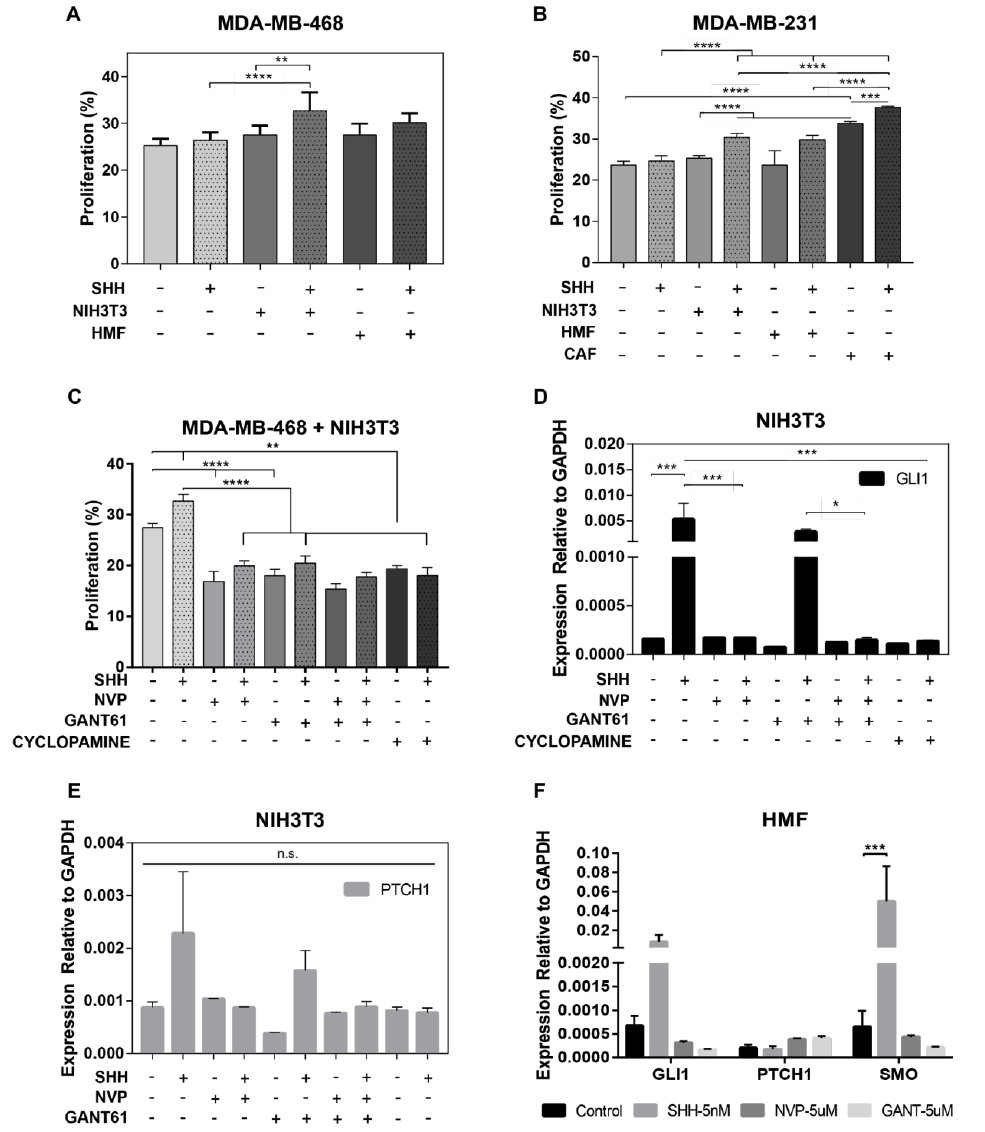
Figure 3. Fibroblasts are a therapeutic target of Hedgehog (Hh) inhibitors in triple negative breast cancer (TNBC). ( A ) Proliferation of MDA-MB-468 in presence and absence of Sonic hedgehog (SHH)-ligand (5 nM) in mono and co-culture with NIH3T3 and human mammary fibroblasts (HMF) cells during 96 h. Data represents mean +/ − SEM of one to four experiments with n = 7–12. ( B ) Proliferation of MDA-MB-231 in presence and absence of SHH-ligand (5 nM) in mono and co-culture with NIH3T3, CAF, and HMF cells during 96 h. Data represents mean +/ − standard error of mean (SEM) of one to four experiments with n = 7–14. ( C ) Proliferation of MDA-MB-468 in co-culture with NIH3T3 and HMFs treated with 5 nM SHH-ligand and Hh inhibitors, NVP, GANT61, and cyclopamine for 96 h. Data represents mean +/ − SEM of two to three experiments with n = 3–8. ( D , E ) Expression levels of glioma associated oncogene family zinc finger 1 ( GLI1 ) and patched1 ( PTCH1 ) relative to Glyceraldehyde-3-Phosphate Dehydrogenase ( GAPDH ) in NIH3T3 cells treated with 5 nM SHH-ligand and Hh inhibitors for 24 h. Data represent mean +/ − SEM of three experiments with n = 2–3. ( F ) Expression levels of GLI1 , PTCH1 , and Smoothened ( SMO ) relative to GAPDH in HMF cells treated with 5 nM SHH-ligand and Hh inhibitors for 24 h. Data represent mean +/ − SEM of three experiments with n = 2–4. Significance was determined via ANOVA analysis * p -value < 0.05, ** p -value < 0.01, *** p -value < 0.001, **** p -value <